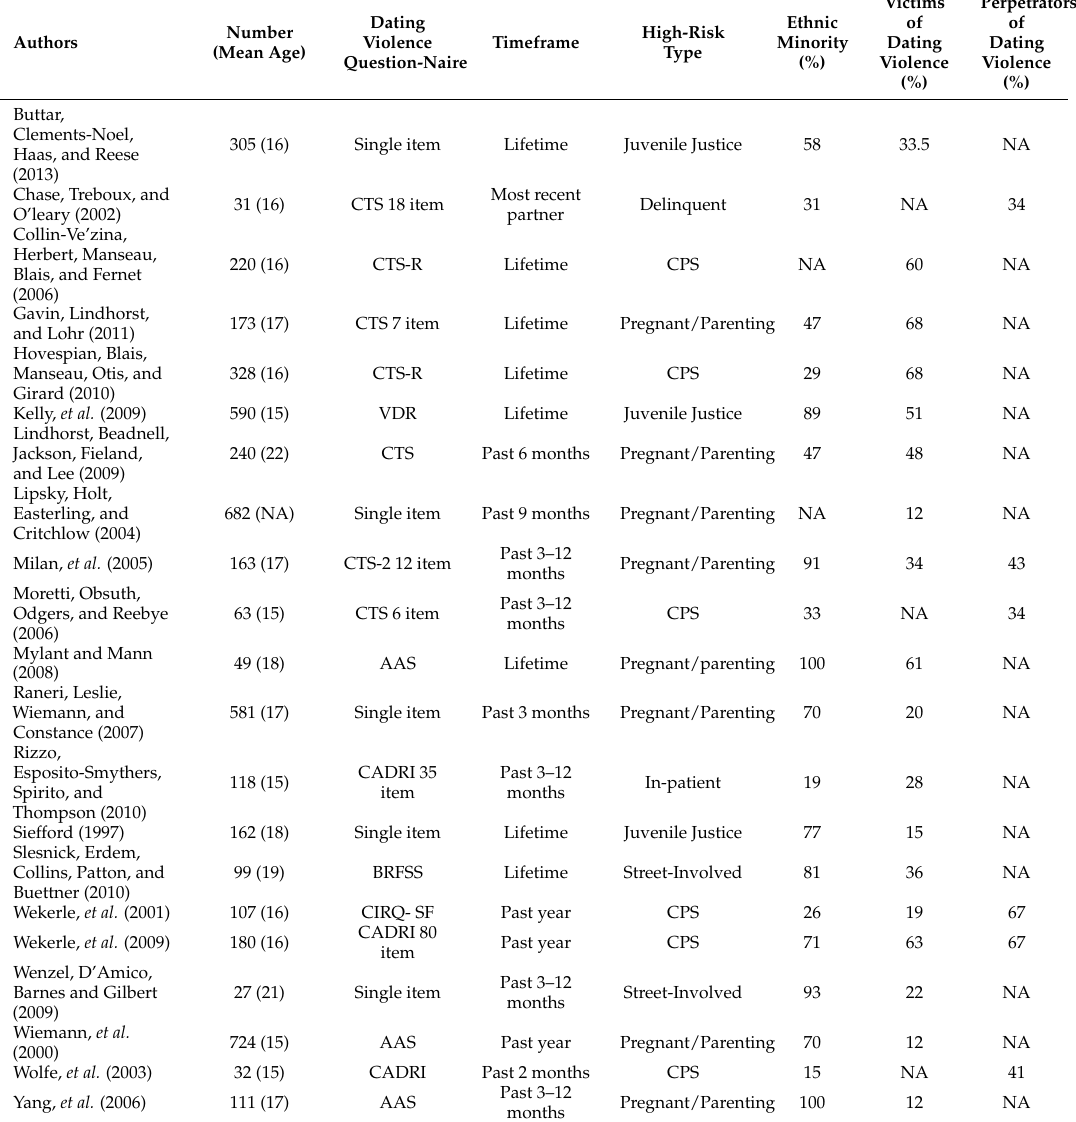
Table 1. Summary of Meta-Analysis Sample Characteristics [3,11–13,29–45].